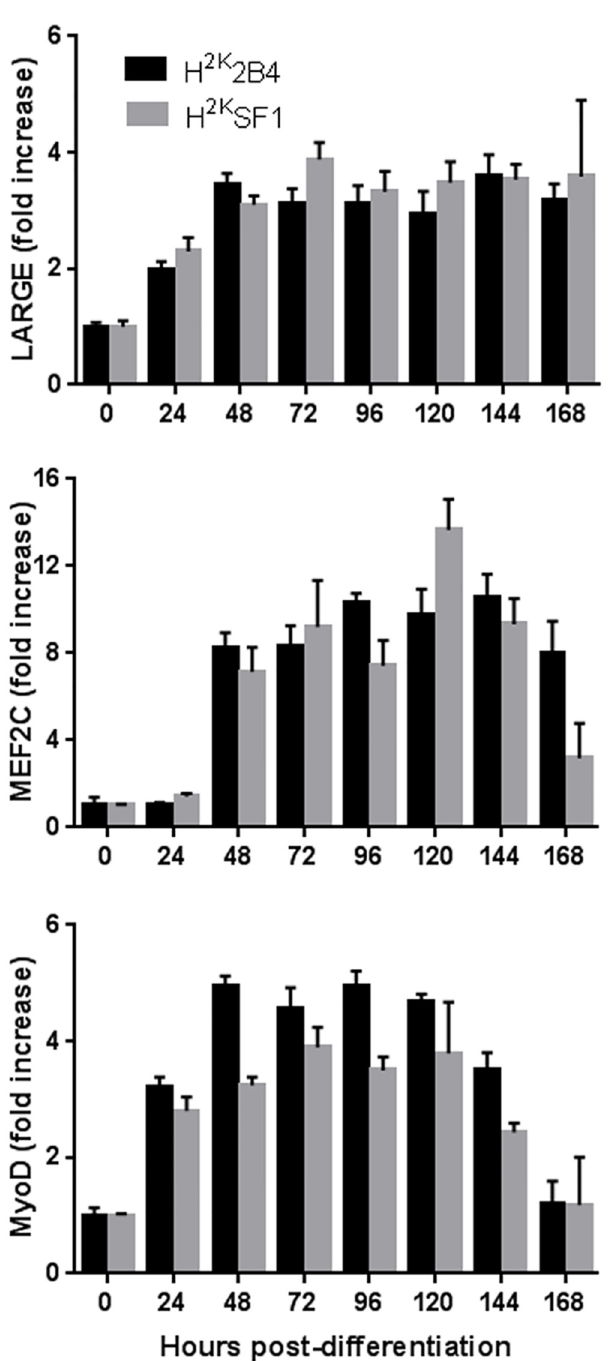
Fig 8. Expression of endogenous LARGE increases during myogenesis in both normal and dystrophic cells. qPCR analysis of cDNA prepared from WT (H 2K 2B4) or mdx (H 2K SF1) cell cultures at the times indicated using primers for endogenous LARGE (upper panel), and for myogenic transcription factors MyoD and MEF2C (lower panels). Expression levels are normalised (using Csnk2a2 + Ap3d1) and shown as fold increase over time-zero (proliferating) levels (Means + S.E.M, N =